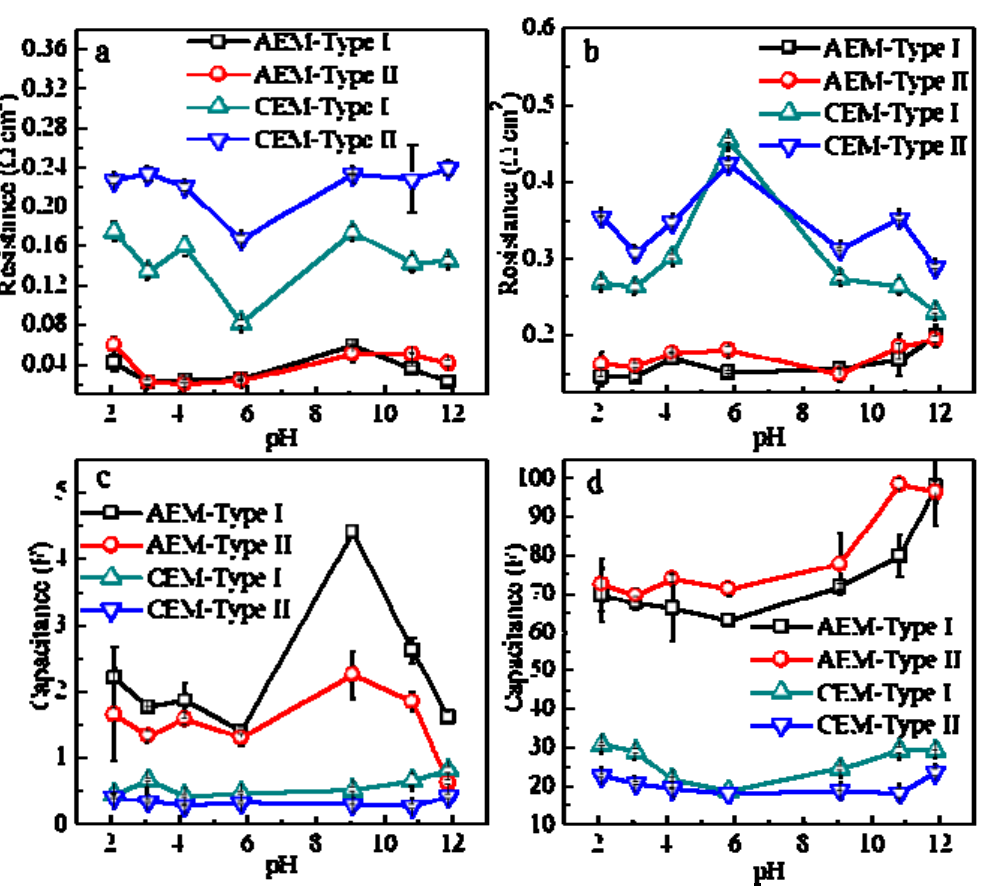
Figure 10. ( a ) Resistance of EDL (R edl ), ( b ) resistance of DBL (R d ), ( c ) effective capacitance of EDL (C edl ), and ( d ) effective capacitance of DBL (C d ) in four ion-exchange membranes as a function of pH.